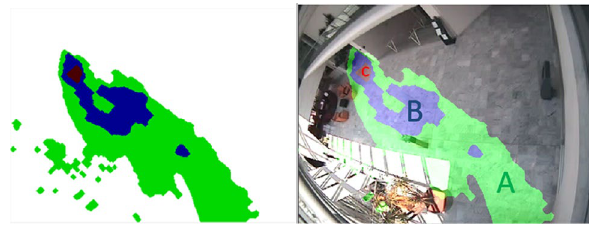
Fig. 2 Scene model (right) obtained by adding the processed coef- ficient matrix to the background model. Marginal areas A , routes B and activity hot spots C are shown in different colours. Scene "Left- Box" from the dataset "CAVIAR"